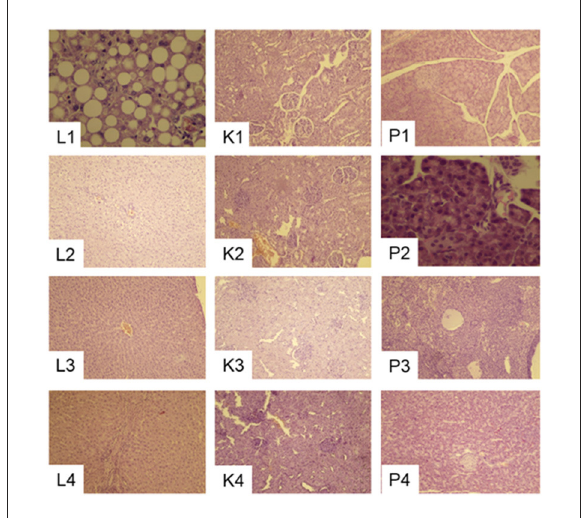
FIGURE8 Effects of PHGDH inhibitor and serine deficiency on Liver (L1–L4), Kidney (K1–K4) and Pancreas (P1–P4) pathological changes (10 × ) in pregnant rats fed 20% casein (experiment 2). 1, 20C; 2, 20C + NCT-503; 3, 20CSD; 4, 20CSD + NCT-503.